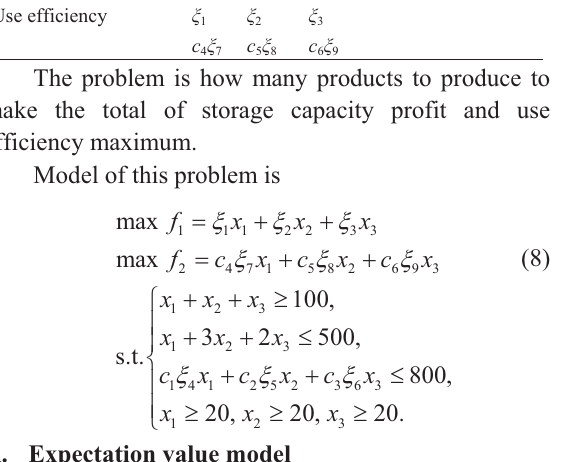
Table 1. The resource demand in a production process Product 1 2 3 Possible use amount Worker amount Storage capacity Profit Use